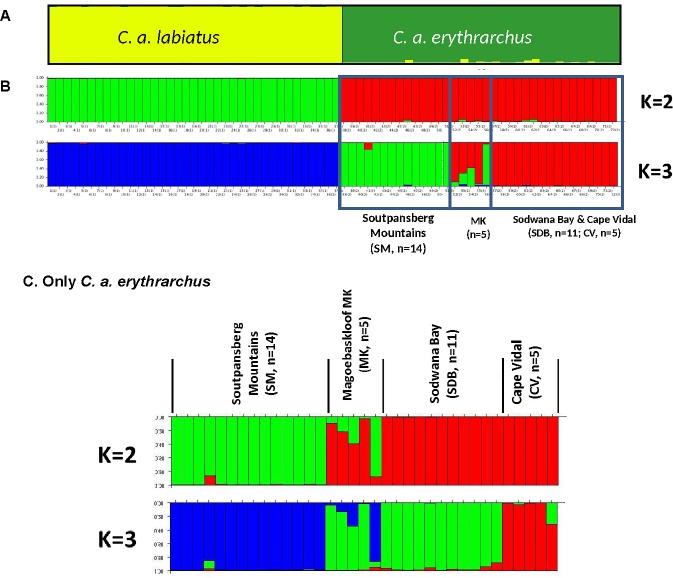
Bayesian cluster analysis in STRUCTURE.(A) The average cluster membership (over 20 runs) for K = 2 of microsatellite genotypes of C. a. labiatus and C. a. erythrarchus. (B) Example bar plots of runs where k = 2 and k = 3. (C) Example histograms from STRUCTURE analysis for K = 2 and K = 3 where only C. a. erythrarchus individuals are included. Each individual is represented by a single horizontal line, with lengths proportional to the estimated membership in each cluster.